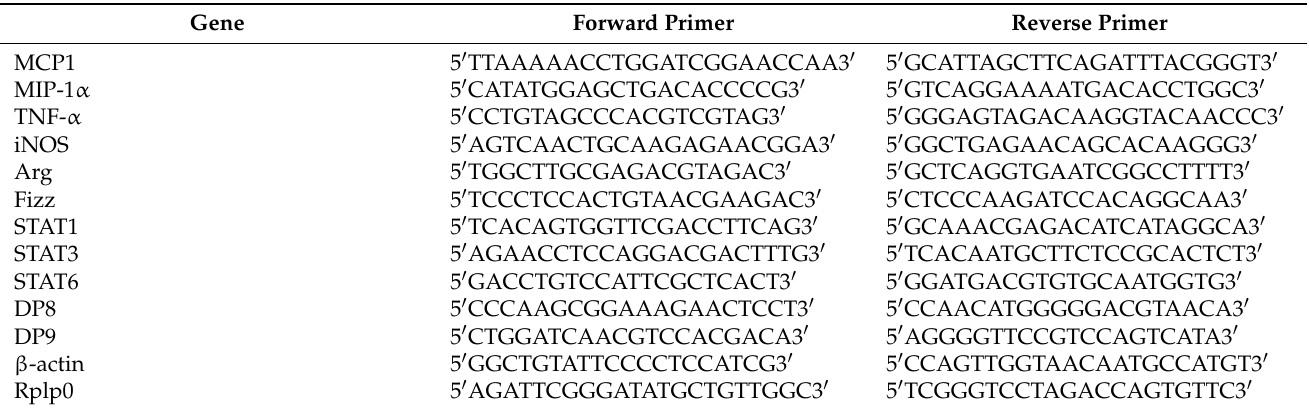
Table 1. Forward and reverse primer sequences used in quantitative real-time (RT)-PCR analysis of the expression of genes of